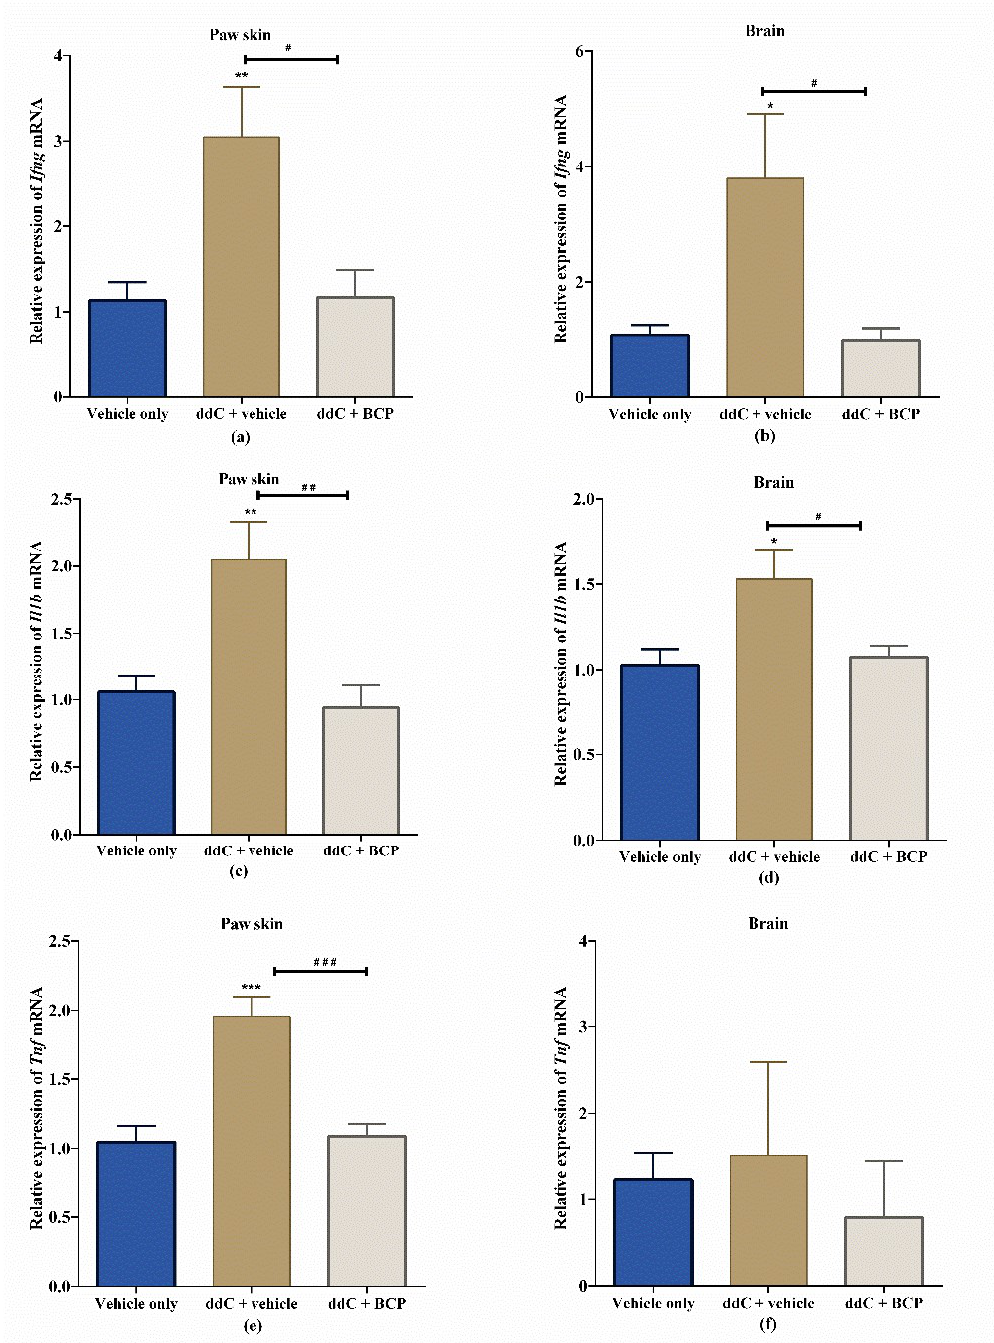
Figure 4. Effect of treatment with 2′-3′-dideoxycytidine (ddC) or ddC plus β-caryophyllene (BCP) on the relative expression of proinflammatory cytokine mRNA in paw skins and brains of female BALB/c mice at day 7 post first ddC dose. Expression of mRNA of ( a ) interferon gamma ( Ifng ) in the paw skin, ( b ) Ifng in the brain, ( c ) interleukin 1 beta ( Il1b ) in the paw skin, ( d ) Il1b in the brain, ( e ) tumor necrosis factor alpha ( Tnf ) in the paw skin and ( f ) Tnf in the brain, on day 7 post-first-injection of ddC. Each bar represents the mean ± SEM of values, except for Tnf in the brain (median and interquartile range), obtained from seven to eight animals. * p < 0.05, ** p < 0.01, *** p < 0.001 compared to control mice (treated with vehicle only) at day 7; # p < 0.05, ## p < 0.01, ### p < 0.001 compared to mice treated with ddC plus vehicle. For ( a – e ) one-way ANOVA was followed by Tukey’s multiple comparisons test and for ( f ) Kruskal–Wallis was followed by Dunn’s multiple comparisons